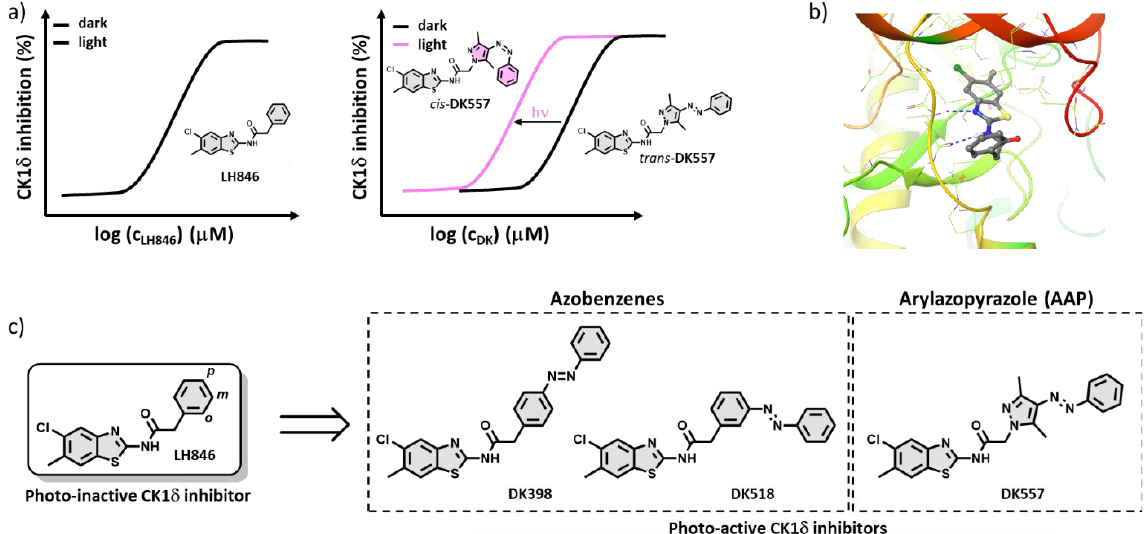
Figure 1. Design of the photoswitchable CK1 inhibitor. ( a ) The concept of light-activated CK1 inhibition; ( b ) molecular docking of LH846 with CK1 δ isoform; ( c ) the original CK1 δ -selective inhibitor LH846 was rendered photo-active by azo-extension in para ( p , DK398 ) and meta ( m , DK518 ) positions and by substituting the azobenzene moiety with the AAP photoswitch ( DK557 ).